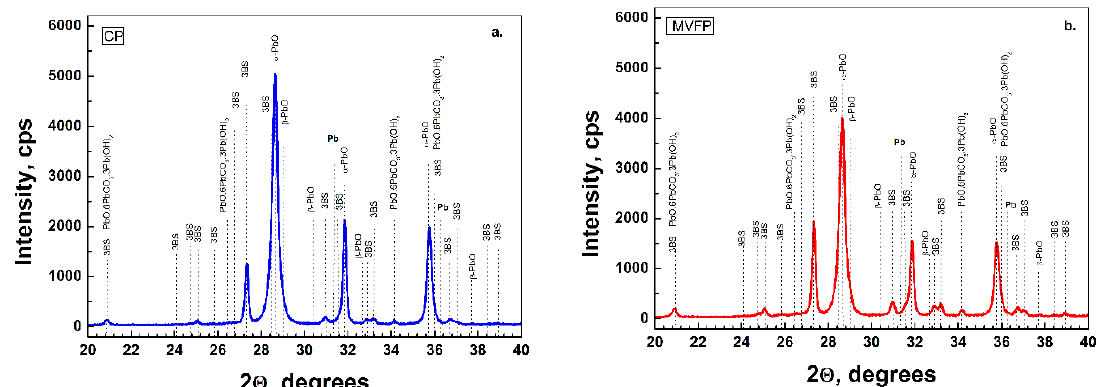
Figure 2. XRD analysis of control paste ( a ) and paste prepared with external application of multivector field ( b ) after mixing.